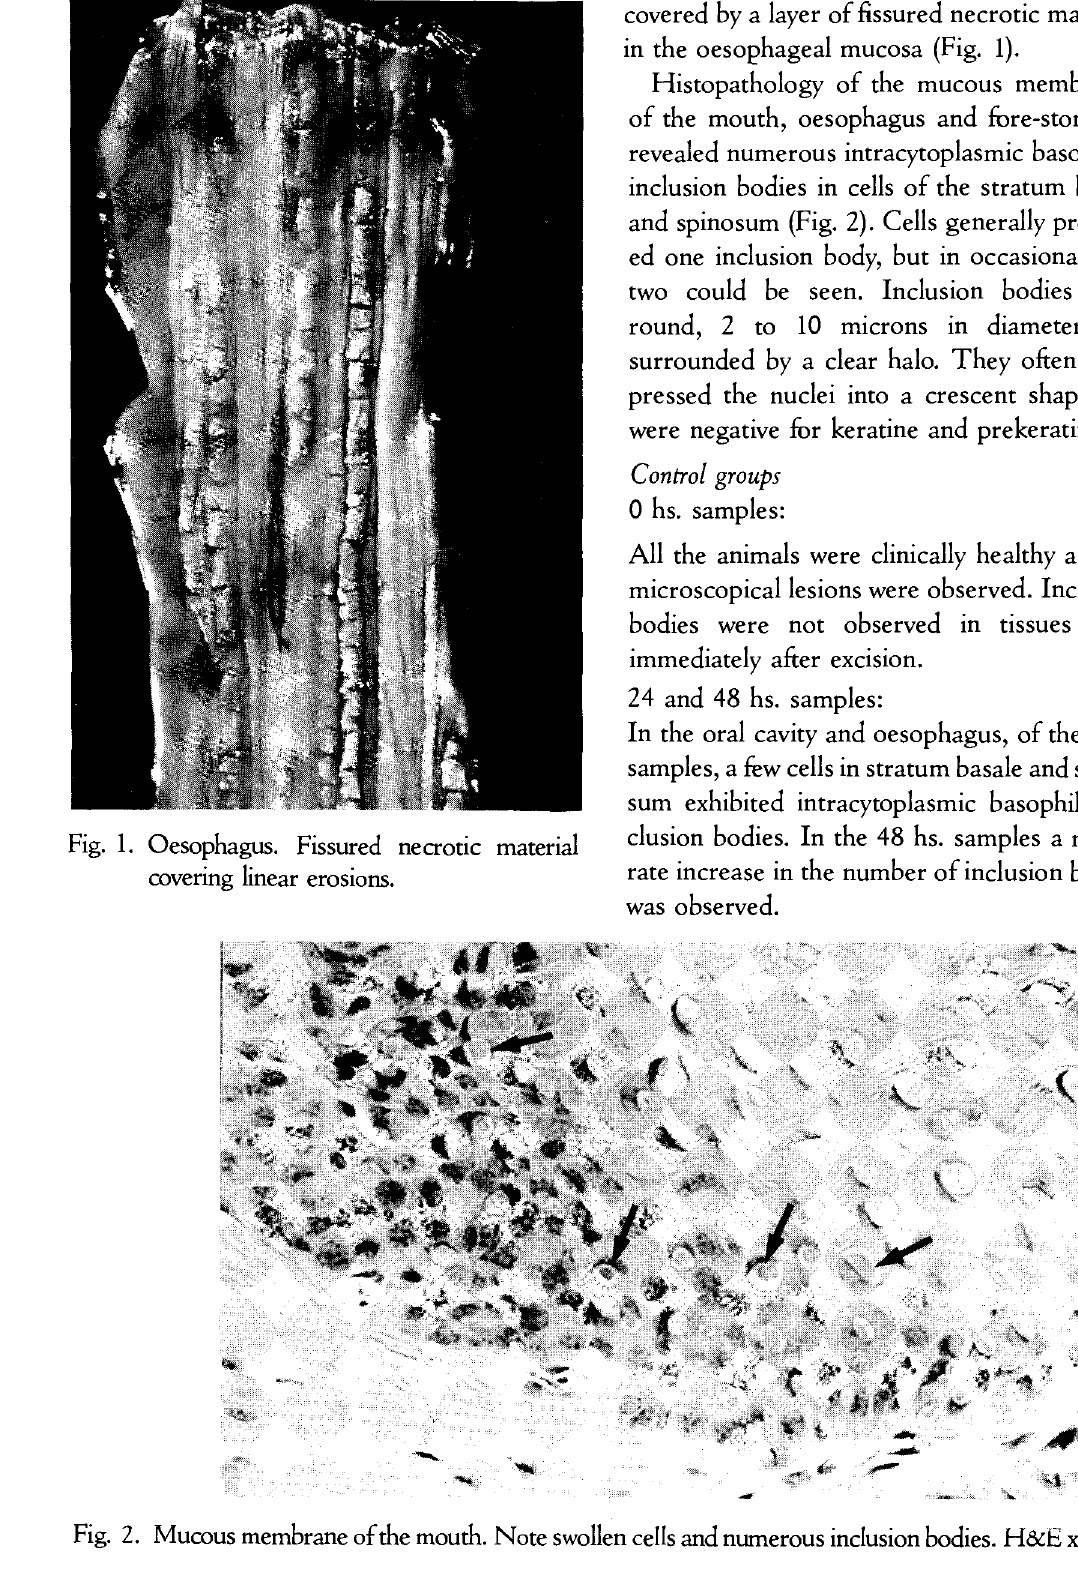
Fig. 2. Mucous membrane of the mouth. Note swollen cells and numerous inclusion bodies. H&E x 450.